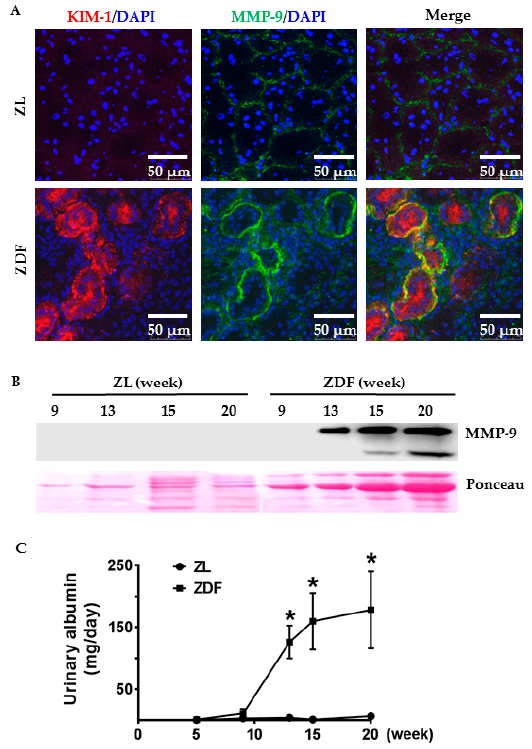
Figure 2. Increased tubular expression and urinary excretion of MMP-9 protein in ZDF rats. ( A ) Cell nuclei were stained by DAPI (blue). Double immunofluorescence staining shows that MMP-9 (green) signal was enhanced on the basolateral membrane of damaged tubules with strong kidney injury molecule-1 (KIM-1) (red) staining in 20-week-old ZDF rats. As expected, KIM-1 staining was absent in normal ZL kidneys. Weak linear MMP-9 staining was detected along normal tubules; ( B ) Representative Western blotting images of MMP-9 and Ponceau red staining show a gradual increase in MMP-9 protein in the urine collected from nine- to 20-week-old ZDF rats, whereas MMP-9 was not detectable in the urine of ZL rats; ( C ) Urinary albumin levels were determined in 24-h urine collected from five- to 20-week-old ZL and ZDF rats. Values are mean ± SEM; n = 4–7; * p < 0.01 vs. age-matched ZL controls.